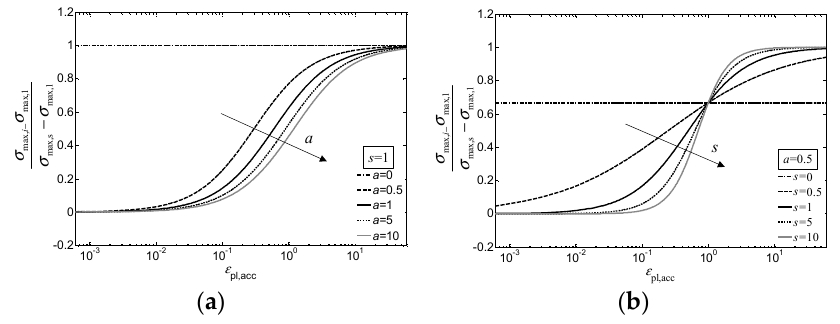
Figure 4. The sensitivity of the proposed Equation (10) to parameters ( a ) a and ( b ) s . Please note that limiting values exist for both